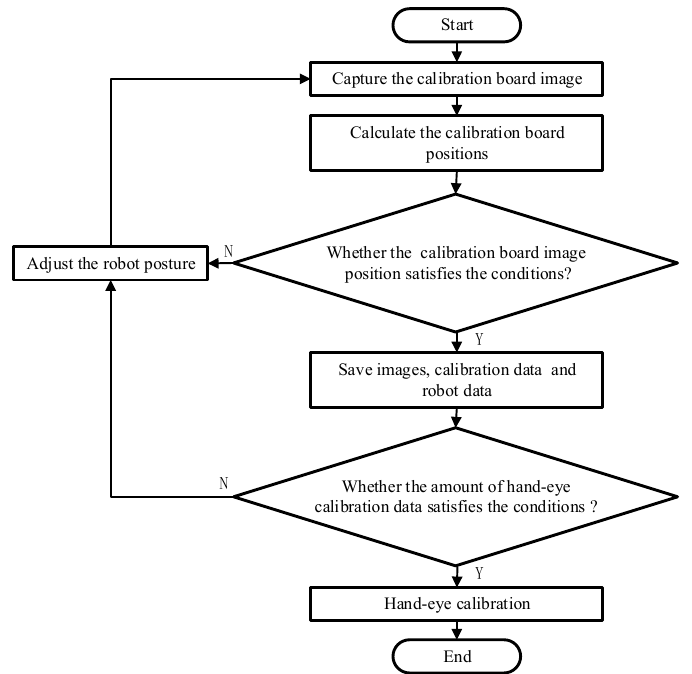
Figure 7. Process of online hand–eye calibration based on ChArUco board.